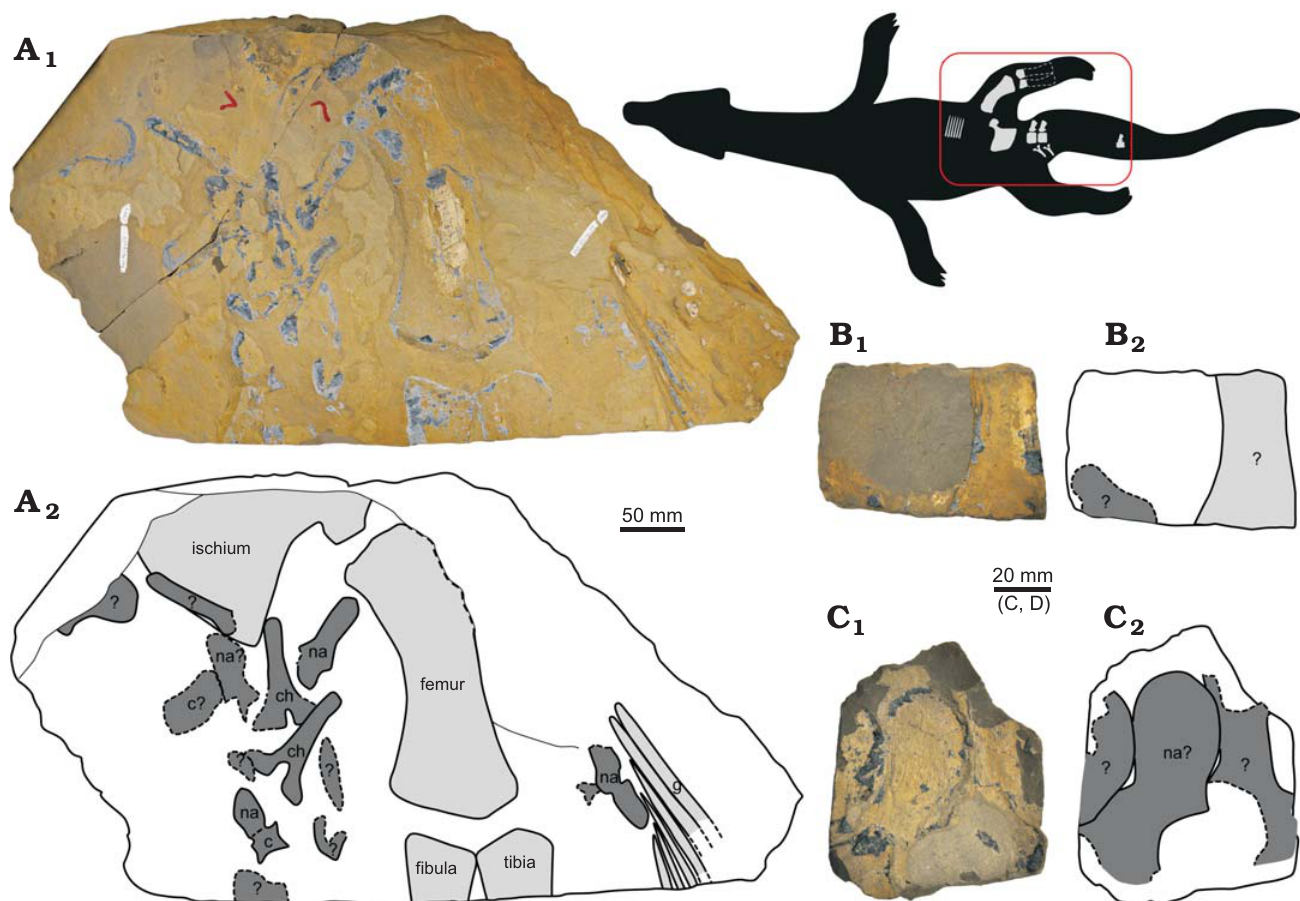
Fig. 2. TMP 1995.116.0023 tentatively identified as aff. Nothosauroidea indet. from the Olenekian, L cirque locality, Ganoid Ridge, Wapiti Lake area, British Columbia, Canada. The specimen consists of two associated larger slabs (A), and two small slabs (B, C) of unclear association. The area where the preserved bones and imprints on the large slab derive from the skeleton is indicated by a red rectangle on black outline drawing based roughly on Nothosaurus giganteus (based on PIMUZ T 4829). A . The two larger slabs containing most of the identifiable bones. Gastralia, appendicular, and girdle elements are in light gray, axial elements in darker gray. B . Small slab with the imprint of two bone fragments, the larger of which might pertain to a girdle or appendicular bone. C . A second small slab with three partially preserved bone remains, probably all representing adjacent neural arch